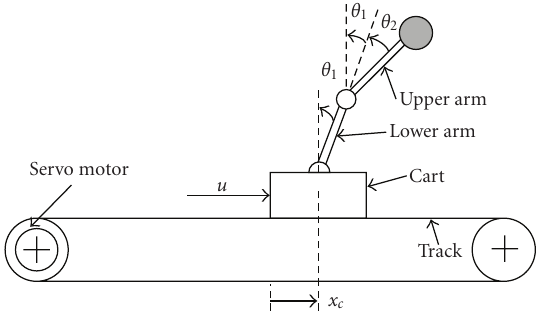
Figure 3: Schematic diagram of the pendulum